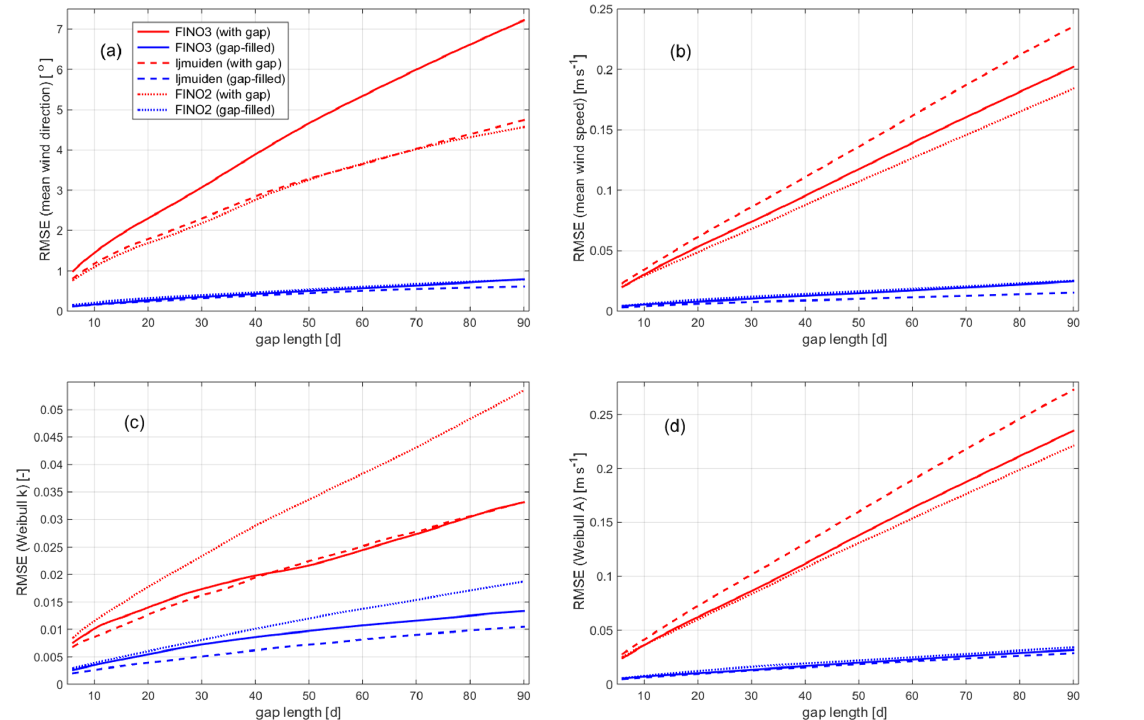
Figure 9. Dependency of impact of data gaps, quantified as RMSE of the four statistical measures – (a) mean wind direction and (b) mean wind speed and Weibull (c) shape and (d) scale parameters, A and k , respectively – derived for gaps with systematically varying start dates, on the length of the data gaps. Results for FINO3 as solid lines, for IJmuiden as dashed lines and for FINO2 as dotted lines (again for incomplete time series in red and for filled time series in blue).